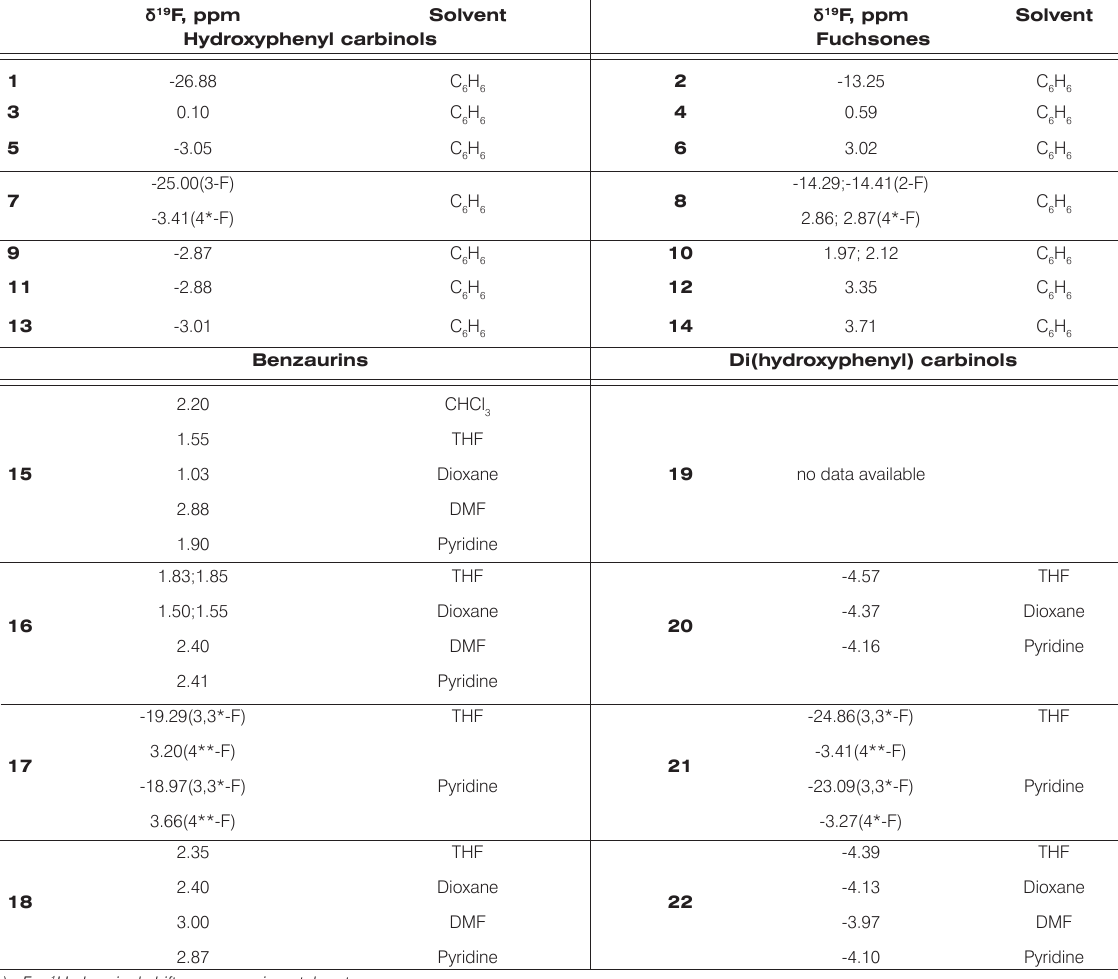
Table 1. 19 F a) chemical shifts of fuchsones, benzaurins and their corresponding